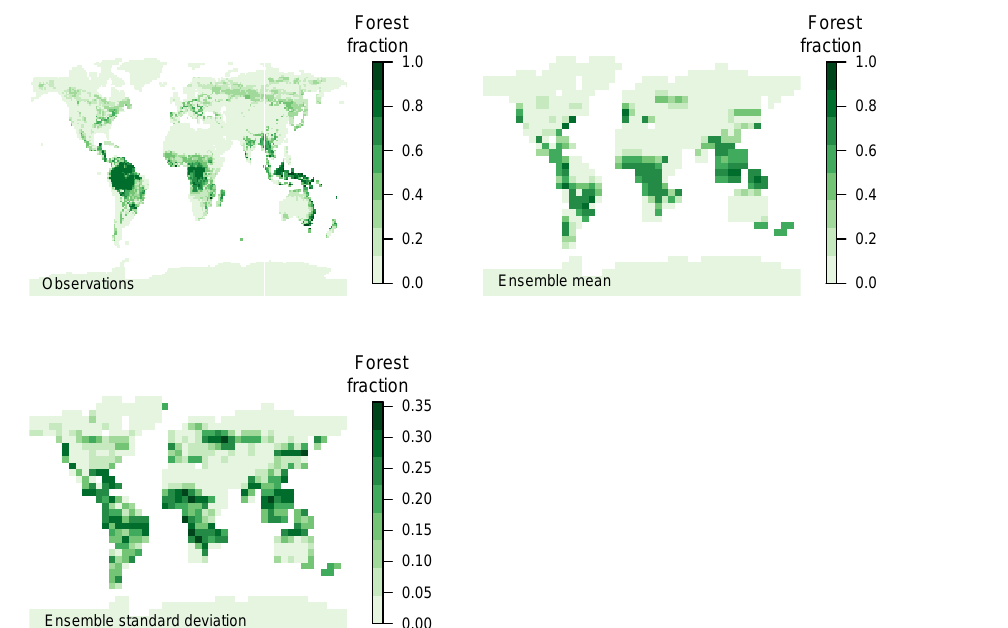
Figure 1. Observations of broadleaf forest fraction (top left panel). Mean (top right panel) and standard deviation (bottom left panel) of broadleaf forest fraction across the 100-member ensemble of